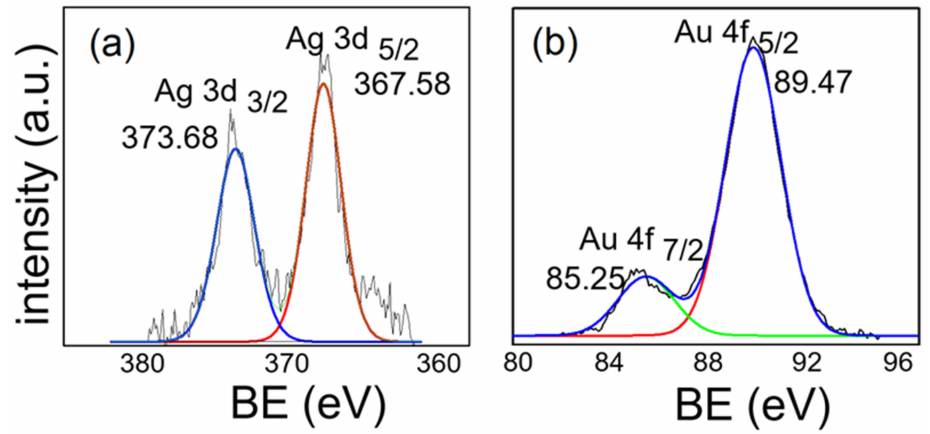
Figure 5. High-resolution XPS spectra of ( a ) Ag3d in Ag_MgGaAl; ( b ) Au4f in Au_MgGaAl. The peaks at 373.68 and 367.58 eV, associated to Ag 3d 3/2 and Ag 3d 5/2 transitions, respectively (see Figure 5a), indicate that on the surface of Ag_MgGaAl silver is present